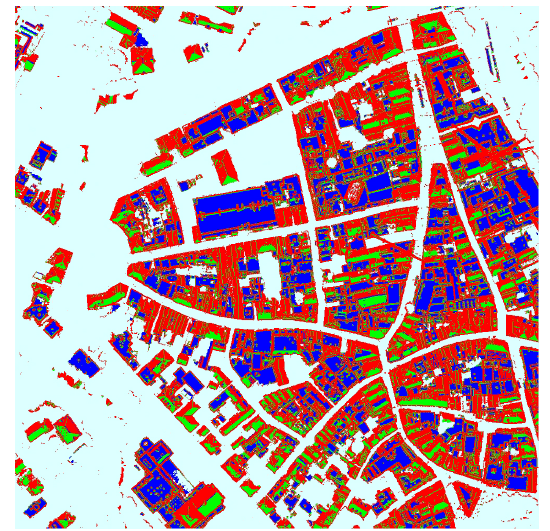
Figure 6: Potential for the use of solar panels of Oldenburg, 500 m x 500 m subset. Blue are flat roofs. Green marked areas are roofs with a slope between 10°-50° and an orientation between 120°-240°. Red marked areas are houses which are not suitable for installing solar cells.